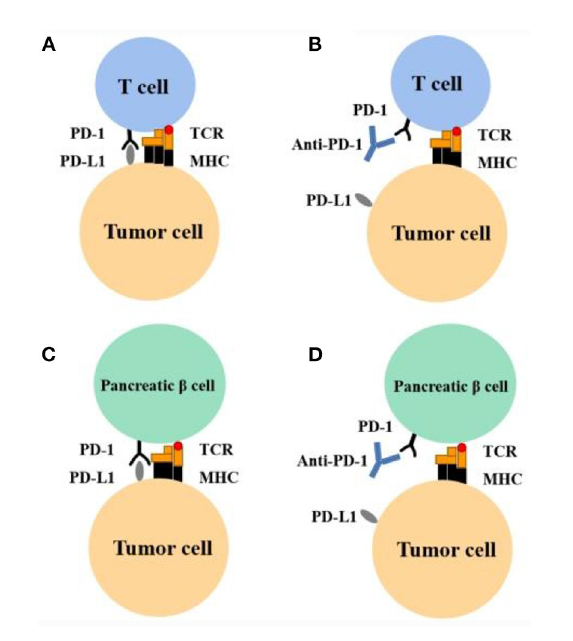
FIGURE1 Mechanism of action of PD-1 inhibitor and hypothesis of association between PD-1 inhibitors and type 1 diabetes. (A) Tumor cells can inactivate T cells and evade the immune system by expressing PD-L1. This leads to the enhanced survival